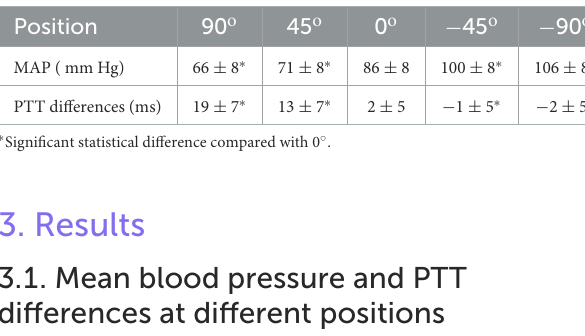
TABLE 2 The overall means and SDs of MAP and PTT differences with the right arm at five positions.